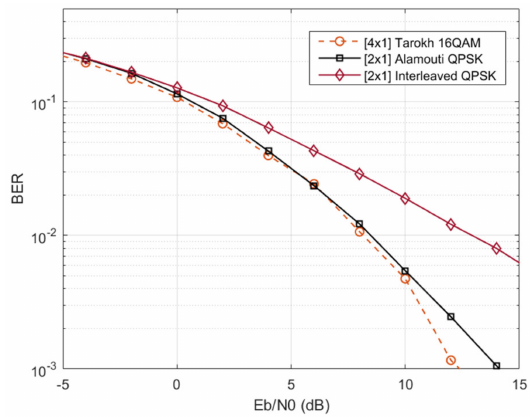
Figure 8. BER performance